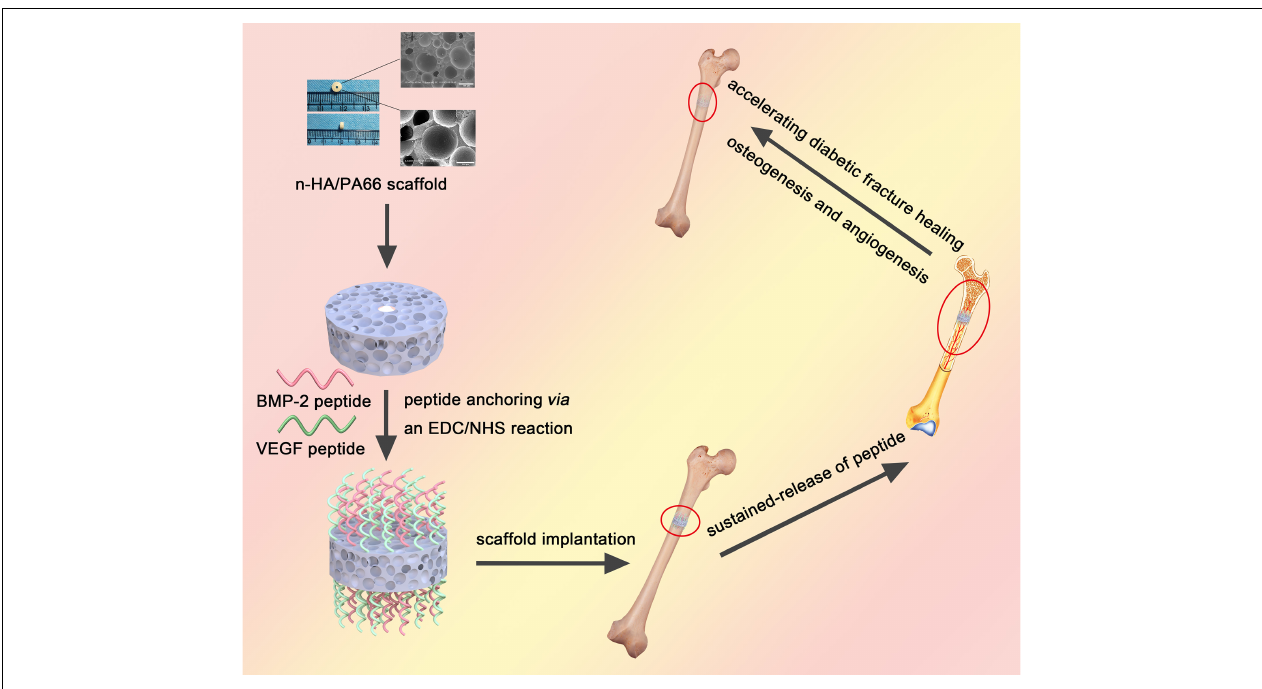
FIGURE 1 | A brief schematic illustrating the synthesis of dual peptide decorated BVHP66 scaffold and its application in diabetic fracture